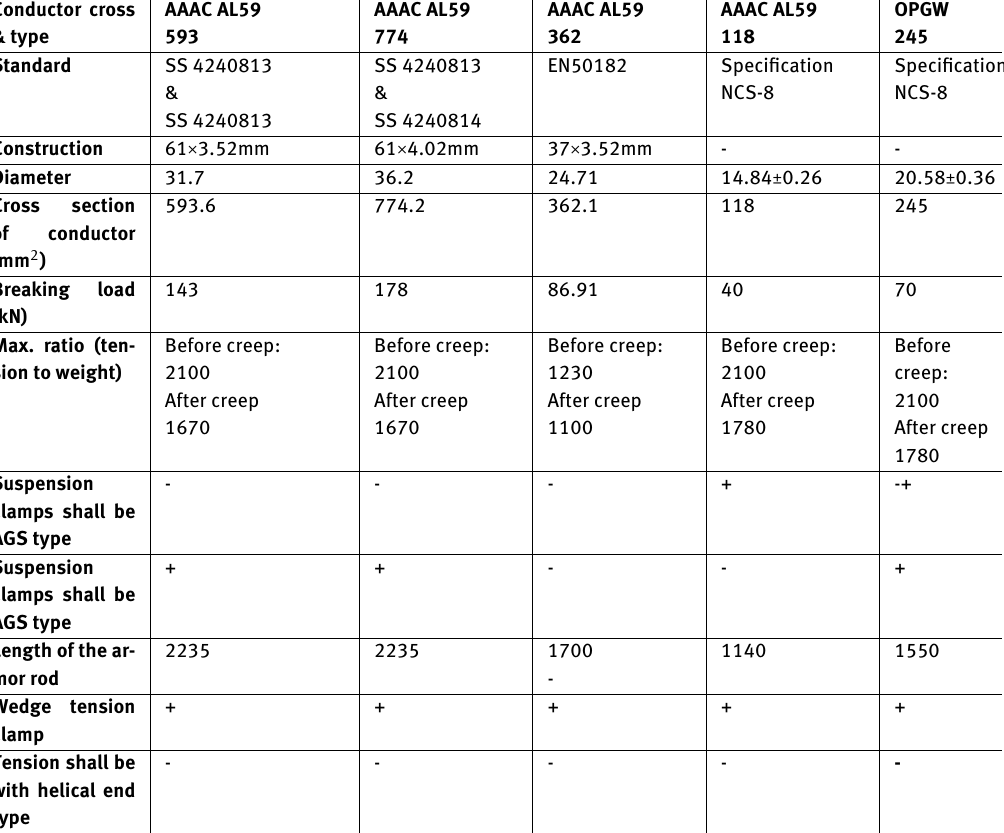
Table 2: Specification NCS 163 for Stockbridge type vibration dampers for distribution and transmission overhead lines Conductor